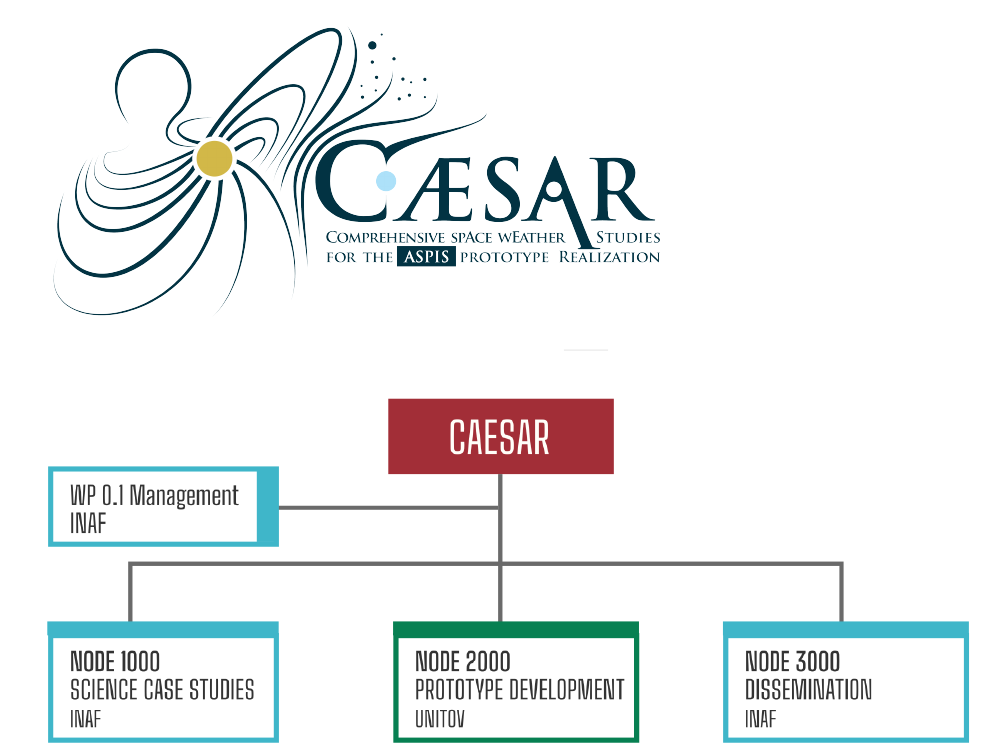
Figure 1. ( Top ) CAESAR logo (courtesy of Carmelo Magnafico). ( Bottom ) Work breakdown structure of CAESAR.